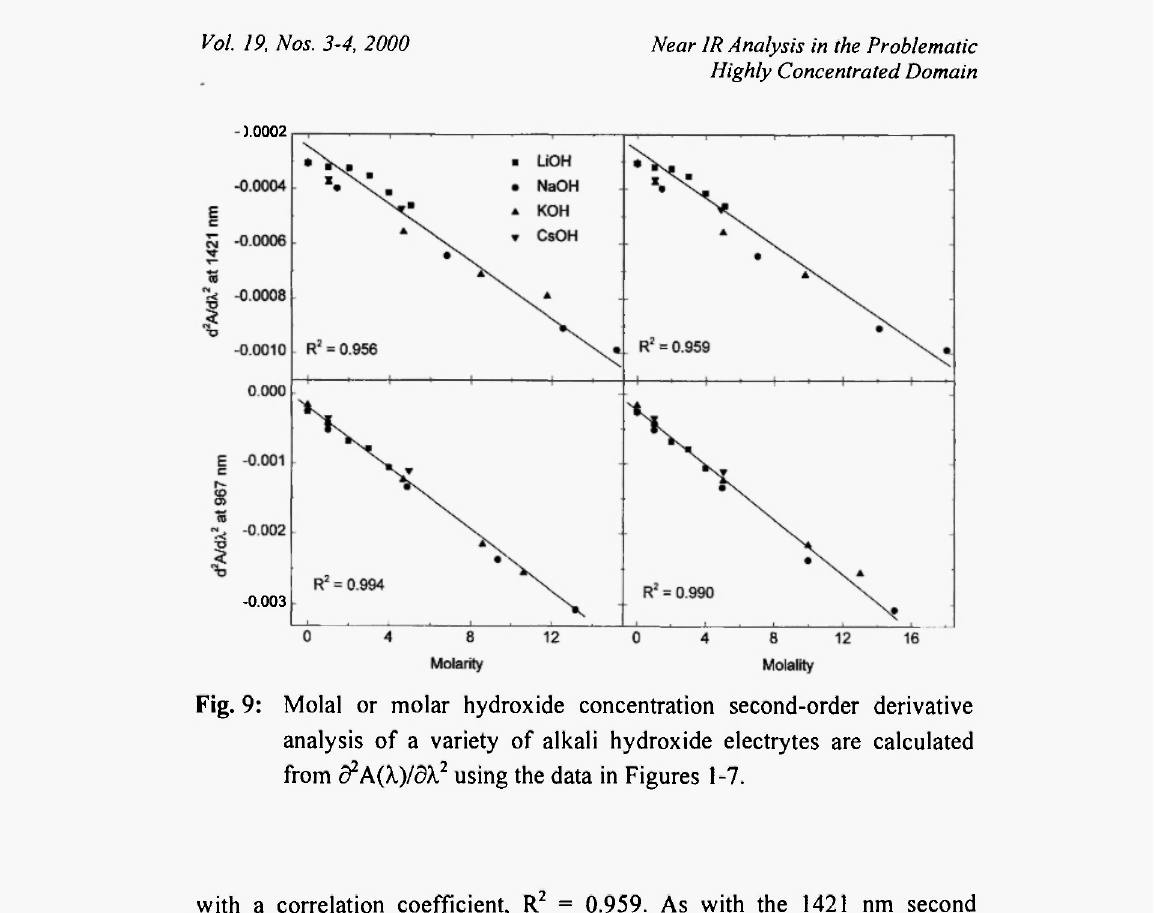
Fig. 9: Molal or molar hydroxide concentration second-order derivative analysis of a variety of alkali hydroxide electrytes are calculated from d 2 Α(λ)/0λ 2 using the data in Figures